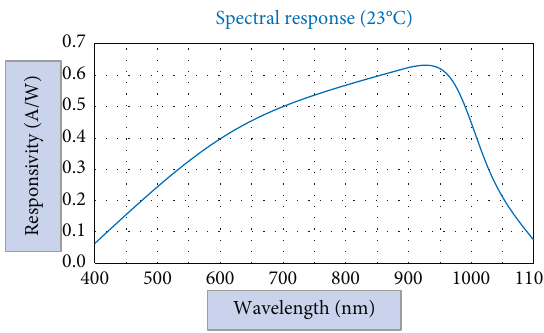
Figure 6: Spectral response curve of the four-quadrant detector.